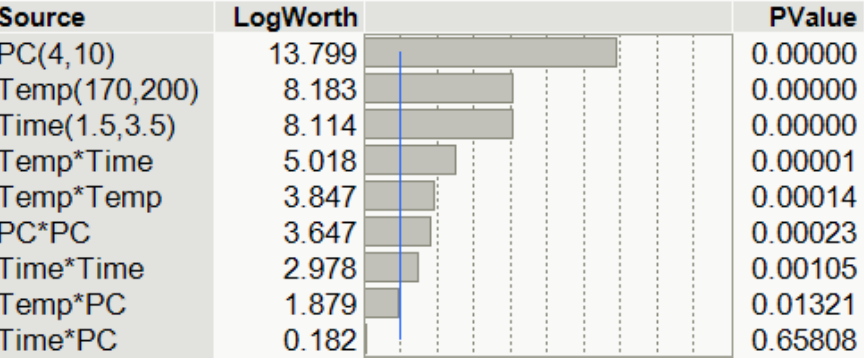
Figure 7. Pareto chart of the main effects obtained from the three levels (3 3 ) full factorial design.